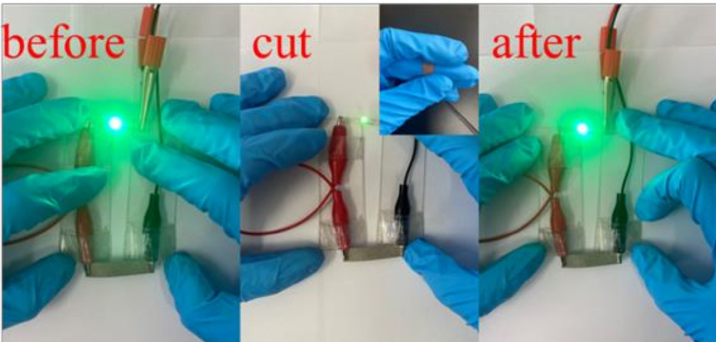
Figure 15. Photographs of LED bead on the composite film before healing, after the cut, and after healing under near-IR irradiation.